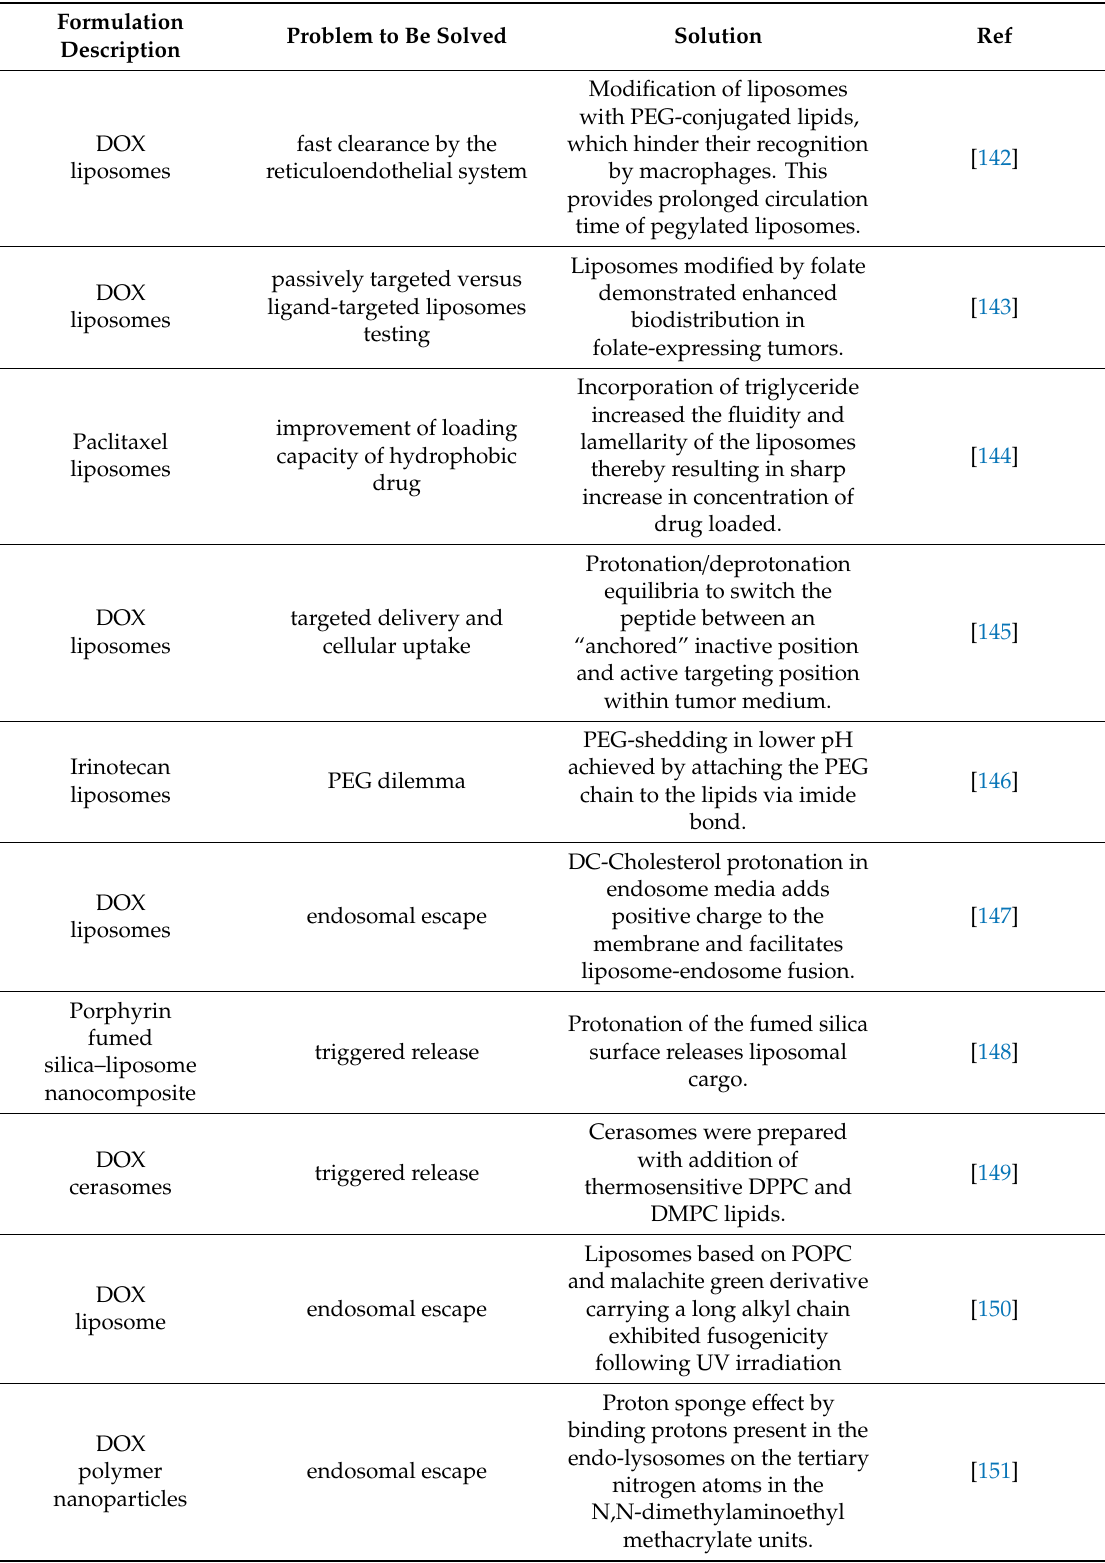
Table 4. Examples of novel successful approaches that utilize nanocarriers to solve typical chemotherapeutic and drug delivery